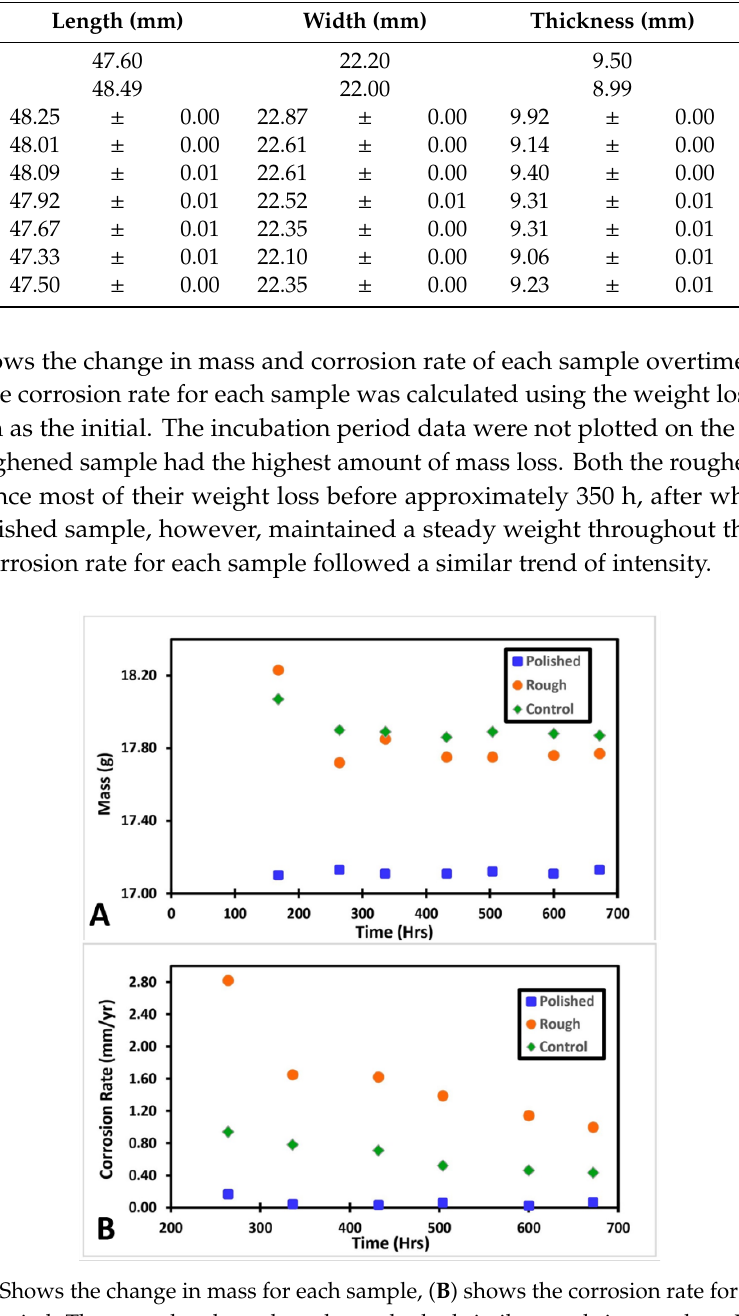
Figure 3. Pictures of the samples were taken to show the change in oxide layer formation over the course of the experiment. All three photo sets show minimal change to the surface of the polished sample. At 168 h the roughened sample had significant growth of a hydrated oxide layer. This layer is also present on the control sample, but significantly less. As the h increased, the amount of hydrated layer growth decreased and a hard oxide layer becomes more visible 4. Discussion The formation of two oxide layers was expected to occur, based on previous reports on Mg corrosion [16,17]. The presence of a hard crust-like MgO was expected to form on the top surface of each sample. On top of the magnesium oxide, an Mg(OH) 2 layer, which is a hydrated oxide layer known as brucite, was expected to form. The rate of corrosion and oxide layer formation was found to be proportional to the samples’ average roughness (Ra) value. The expected corrosion reactions occurring within the salt fog environment include [16,17]. Cathodic Hydrogen Evolution: